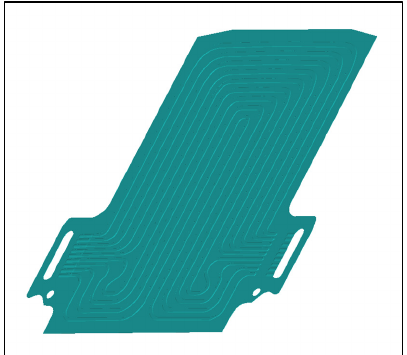
Figure 3. CAD image after 3D laser scanning.